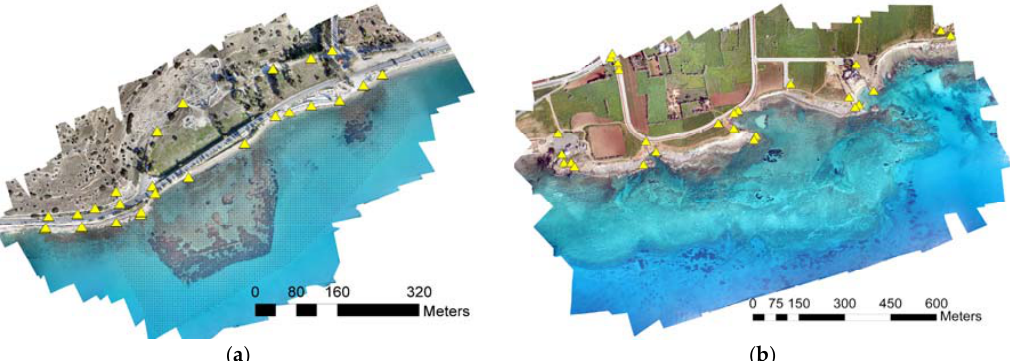
Figure 11. The two test sites. Amathounta ( a ) with lidar data over a 5 m grid (overlaid) and Ag. Napa ( b ) with original lidar data. On the latter, the data are not overlaid due to high density, which would completely cover the photo.